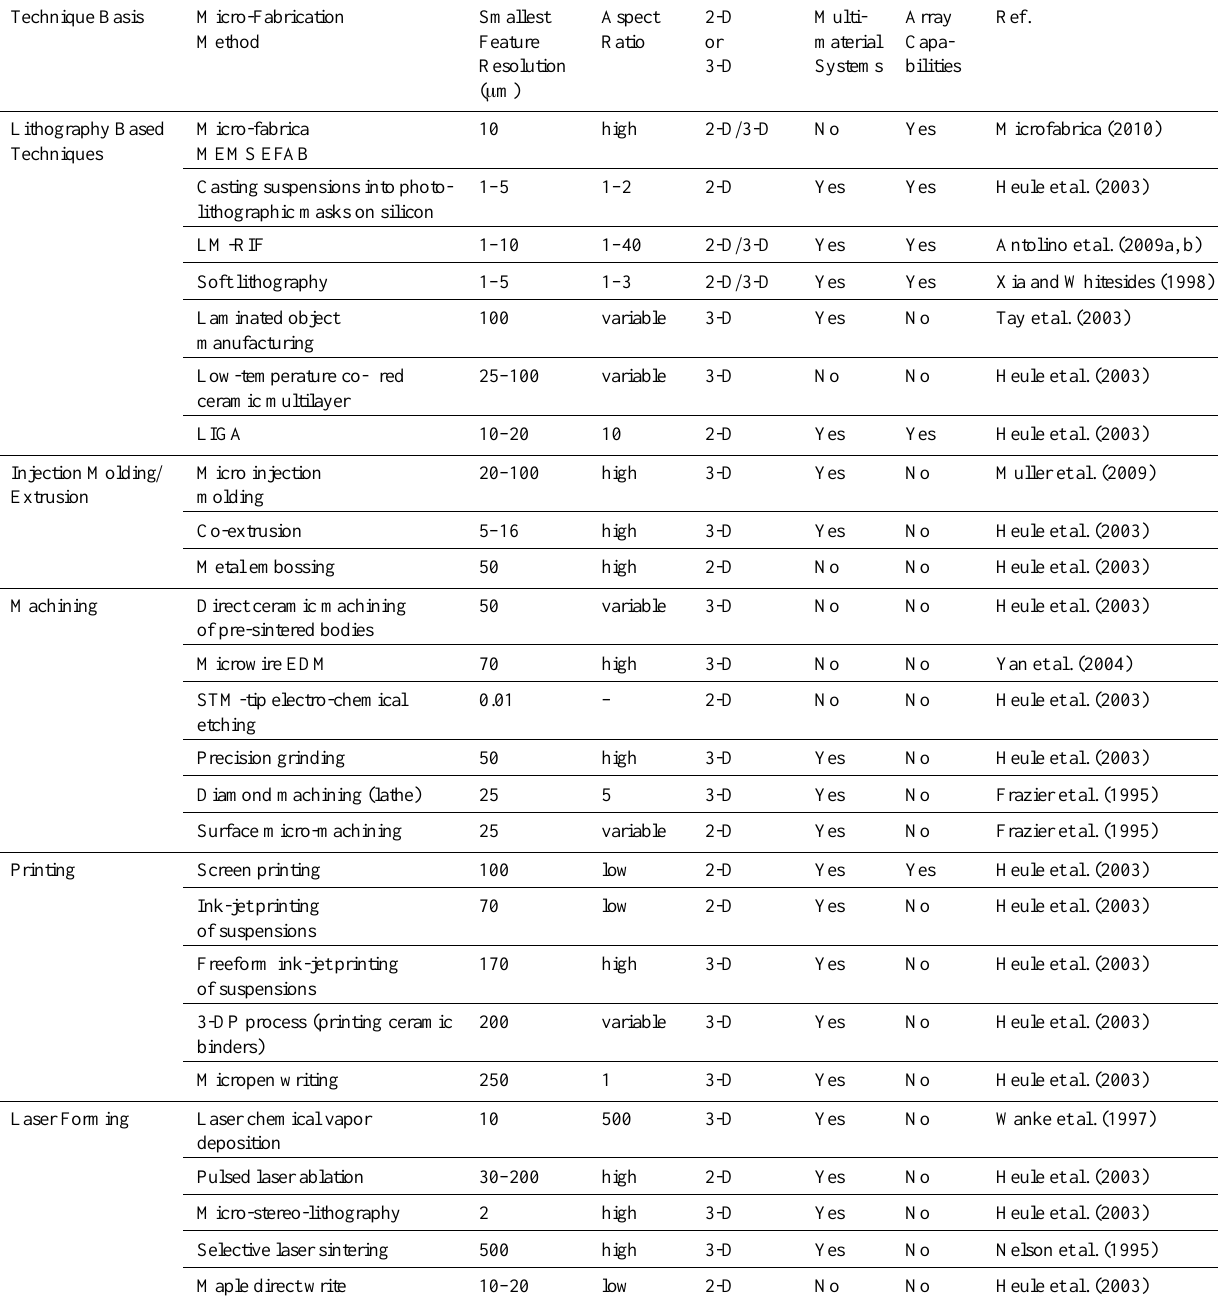
Table 1. Manufacturing methods for micro components are summarized in terms of smallest feature resolution, aspect ratio, multi-material system capability, and array manufacturing capability. Furthermore, the basis for the technique is used to classify the various methods in terms of lithography, injection molding, machining, printing, and laser forming. The developed LM-RIF process is listed under lithography techniques and outlined in